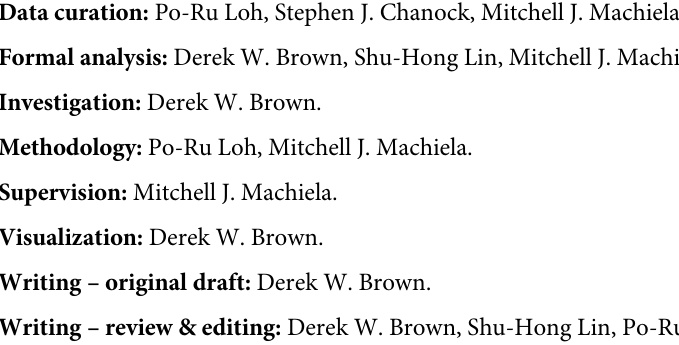
S5 Table. Associations of telomere length-associated variants from Li et al. (2020) with autosomal SCNAs. S6 Table. Mendelian randomization results using variants and summary statistics from Li et al. (2020). S7 Table. Association between genetically-predicted telomere length and chromosome X SCNAs by event type and copy number change. S8 Table. Association between genetically-predicted telomere length and chromosome Y loss by log R 2